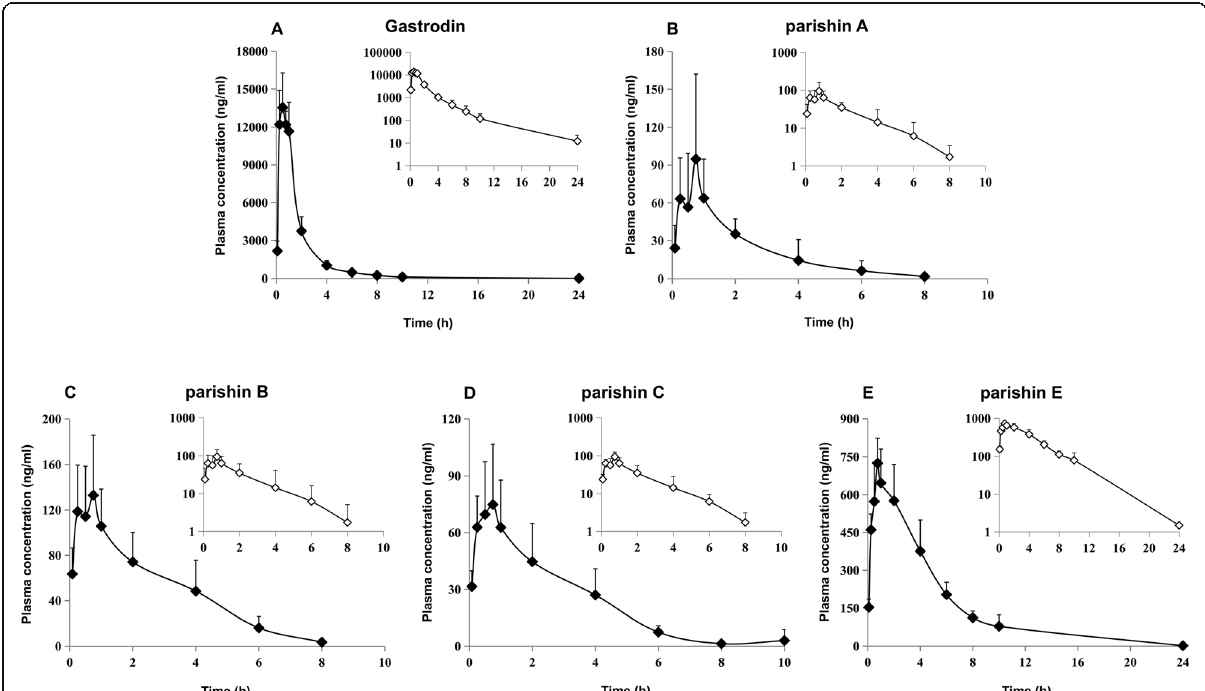
Fig. 3 Mean plasma concentration-time profiles of gastrodin ( a ), parishin A ( b ), parishin B ( c ), parishin C ( d ), and parishin E ( e ) in the Sprague – Dawley rat after oral administration the extracts of G. elata . Each point represents the means ±